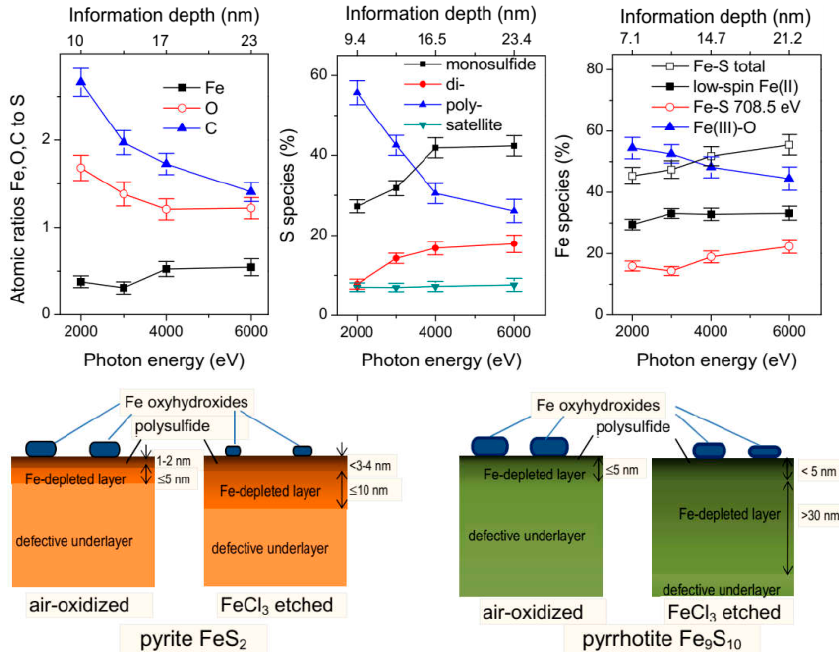
Figure 3. Atomic ratios and the results of fitting of the S 2p and Fe 2p spectra as a function of excitation photon energy for pyrrhotite leached in acidic 0.5 M FeCl 3 solution (top panels), and scheme illustrating layered structures of pyrite and pyrrhotite oxidized in air and the aqueous solution as derived from HAXPES and XANES. Adapted from [88] with permission from Elsevier.